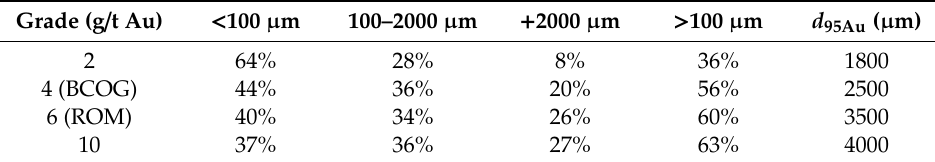
Table 4. Summary of gold particle size distribution by mass across di ff erent grades based on 2000–5000 t trial process plant lots.